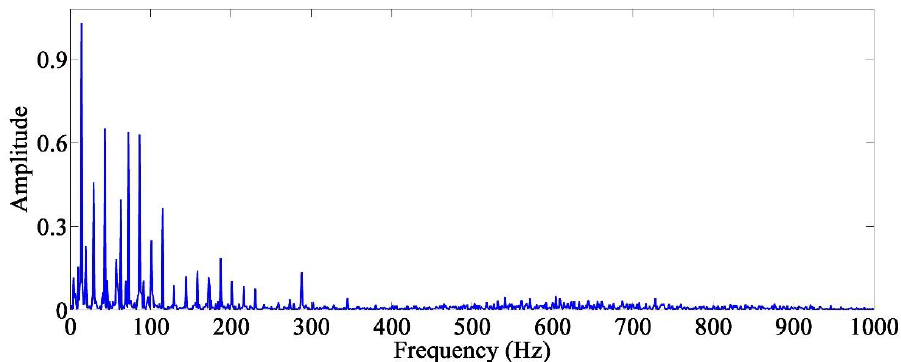
Figure 8. The Hilbert envelope spectra of the extracted fault signal after kernel-independent component analysis (KICA).